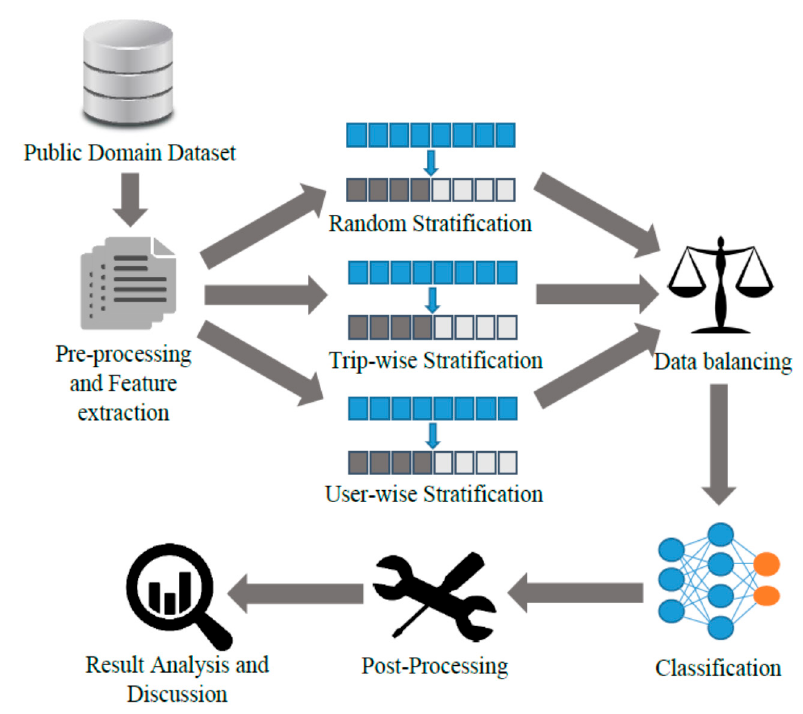
Figure 1. Proposed Methodology of the study.